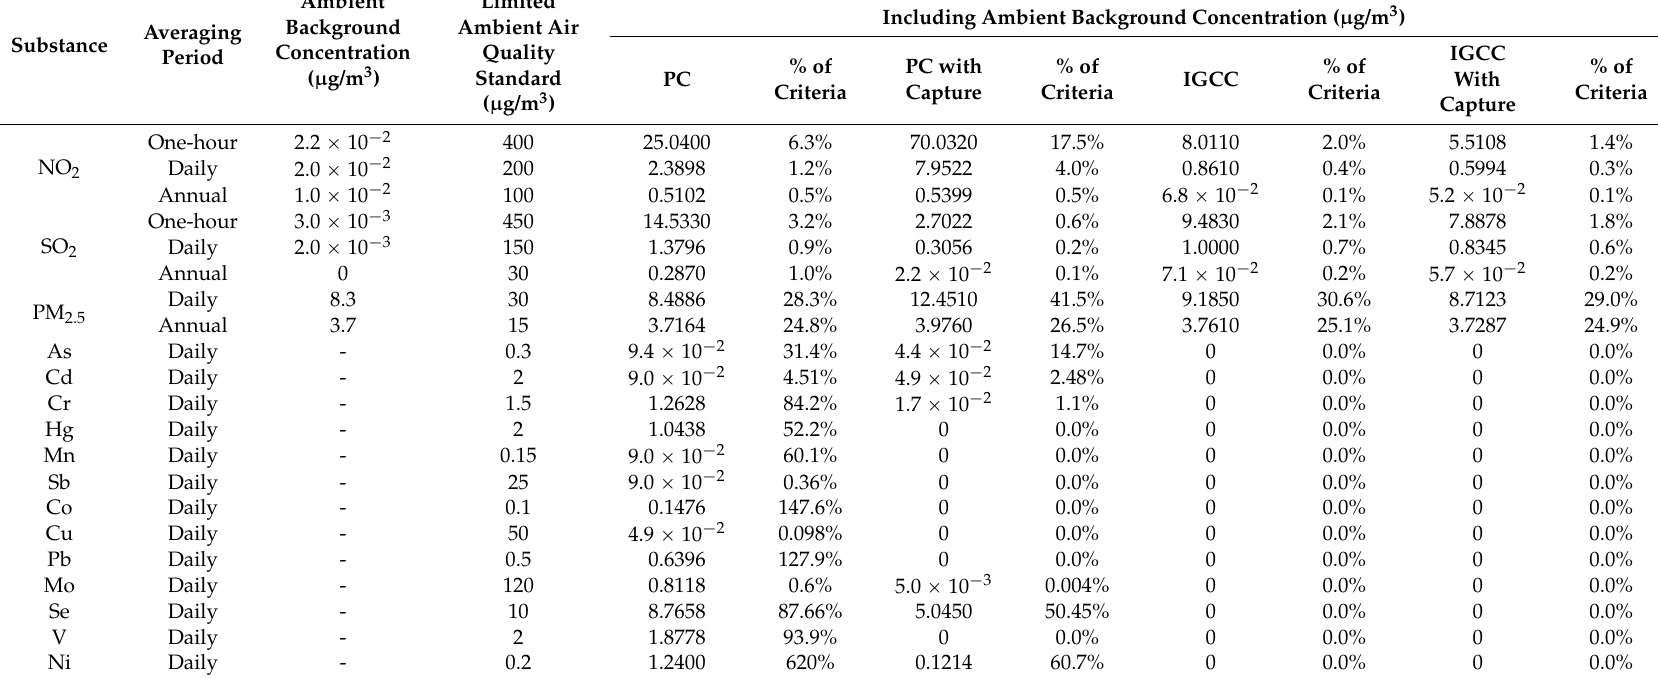
Table 11. AERMOD results: maximum predicted ground-level concentration including background